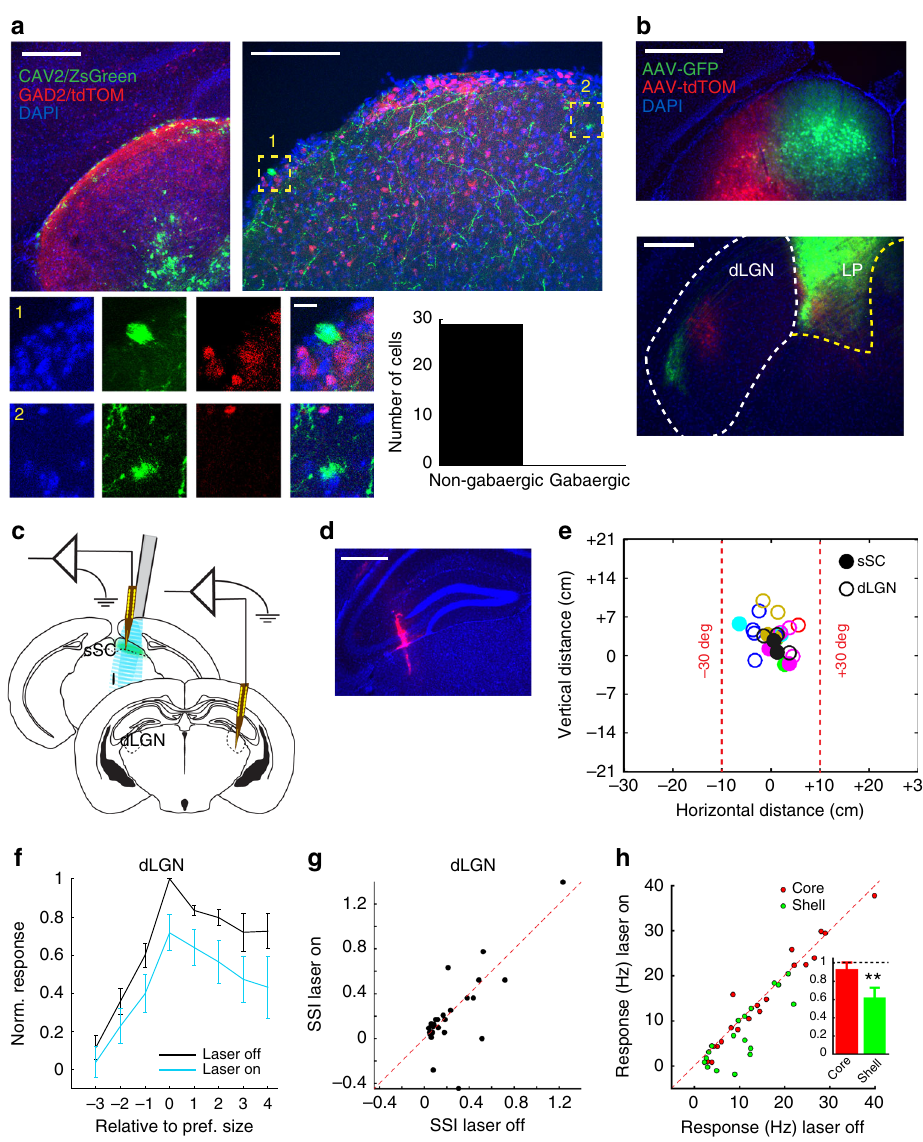
Fig. 3 The sSC increases dLGN gain via excitatory projection. a Top left, coronal slice of dLGN of a Gad2 x Ai14 tdTomato reporter mouse transfected with a retrograde CAV2 virus with a ZsGreen expressing vector. Scale bar is 205 µ m. Top right, coronal slice of sSC in the same experiment showing retrogradely labeled neurons (green) and inhibitory neurons (red). Scale bar is 100 µ m. Bottom left, 1 and 2 show magni fi cations of labeled cells indicated at top right. Scale bar is 10 µ m. Bottom right, all 28 labeled cells were Gad2-Cre negative. b Top, coronal slice of SC injected medially with AAV expressing GFP and more laterally with AAV expressing tdTomato. Scale bar is 500 µ m. Bottom, coronal slice from the same experiment showing sSC innervation of the dLGN. Dashed lines show outline of dLGN (left) and LP (right). Scale bar is 250 µ m. c Laminar recording electrodes in the dLGN and sSC of anesthetized Gad2-Cre mouse, expressing channelrhodopsin-2 in the sSC, with a laser-coupled fi ber placed above the sSC. d Example trace of DiI (red) left in the dLGN by recording electrode. DAPI in blue. Scale bar is 500 µ m. e Distribution of receptive fi eld centers for this set of experiments. Colors indicate the different experiments. Receptive fi eld sizes are not indicated. f Optogenetic inhibition of sSC reduced visual responses in the dLGN (optogenetic effect p = 7.0 × 10 -6 , interaction of optogenetics and size p = 0.95, two-way ANOVA, 6 mice, 26 units). Size is the rank of the stimulus size in a recording, counted from the preferred stimulus in that recording. Error bars indicate s.e.m. g Surround suppression in dLGN was unchanged by optogenetic inhibition of sSC ( p = 0.95, Wilcoxon test, 6 mice, 26 units). h Optogenetic inhibition reduced responses to the largest size gratings in the dorsal (shell) part of the dLGN ( p = 0.004, paired t -test, 6 mice, 18 units) and not the ventral (core) part ( p = 0.59, paired t -test, 6 mice, 19 units). Inset shows mean and s.e.m.